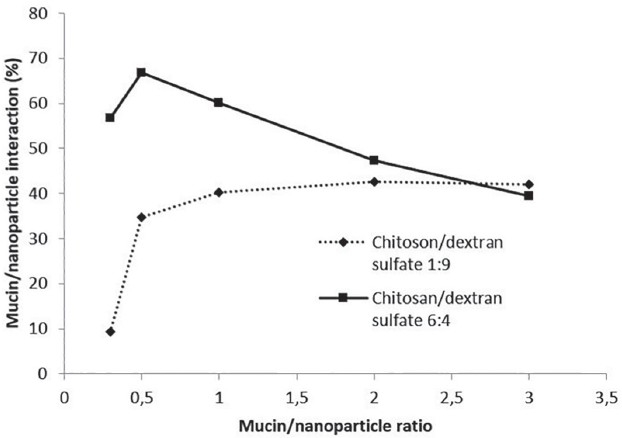
FIGURE 5 - Mucin and insulin-loaded nanoparticles interaction